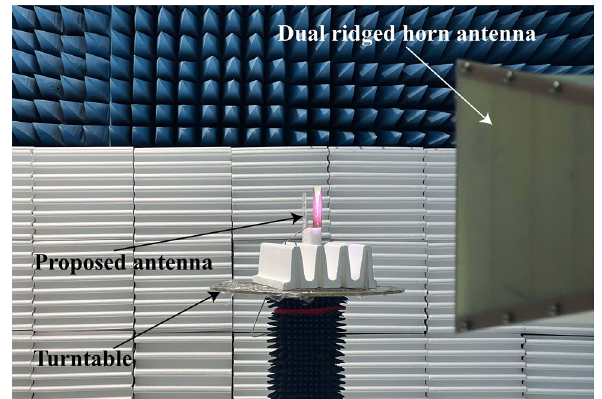
Figure 10. The measurement system in microwave anechoic chamber.